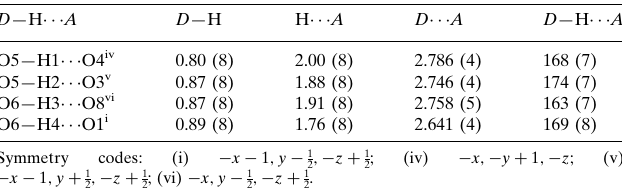
Hydrogen-bond geometry (A˚ , (cid:2)